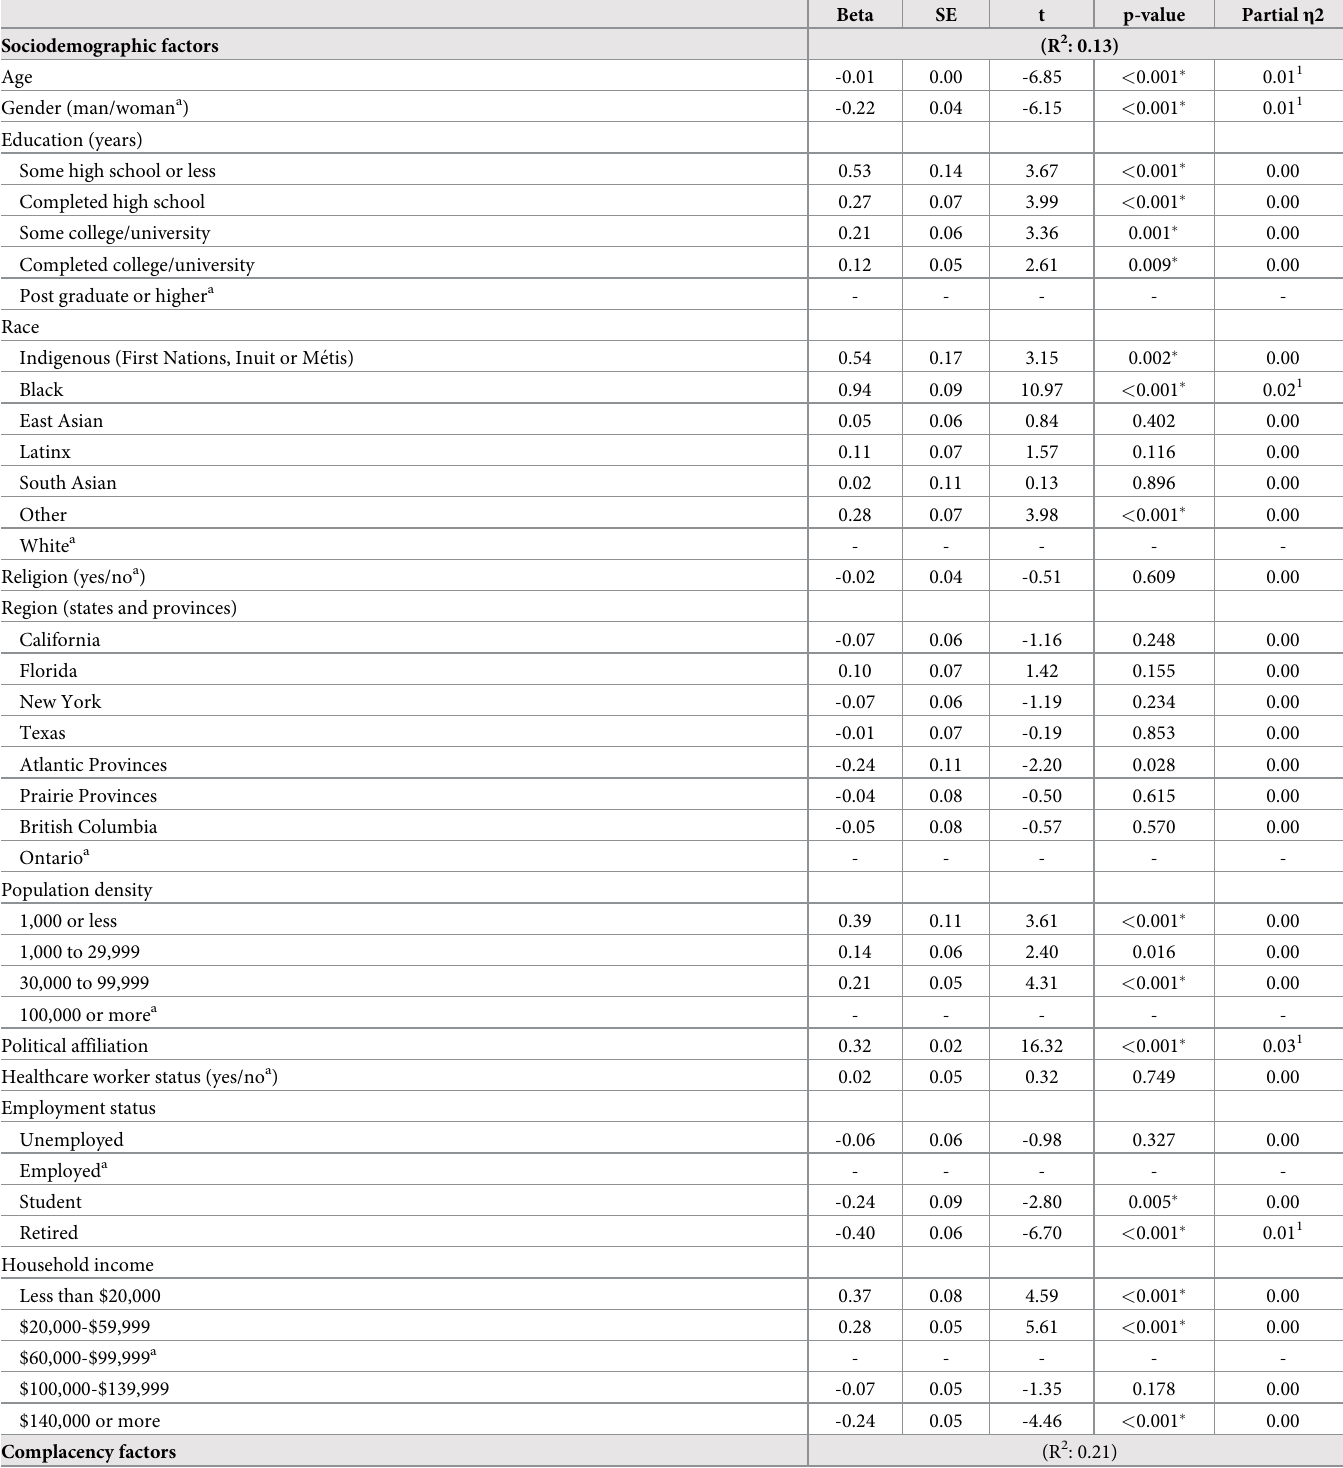
Table 2. Univariate analyses examining the relationship between COVID-19 vaccine hesitancy and sociodemographic, complacency, confidence, and other psycho- logical